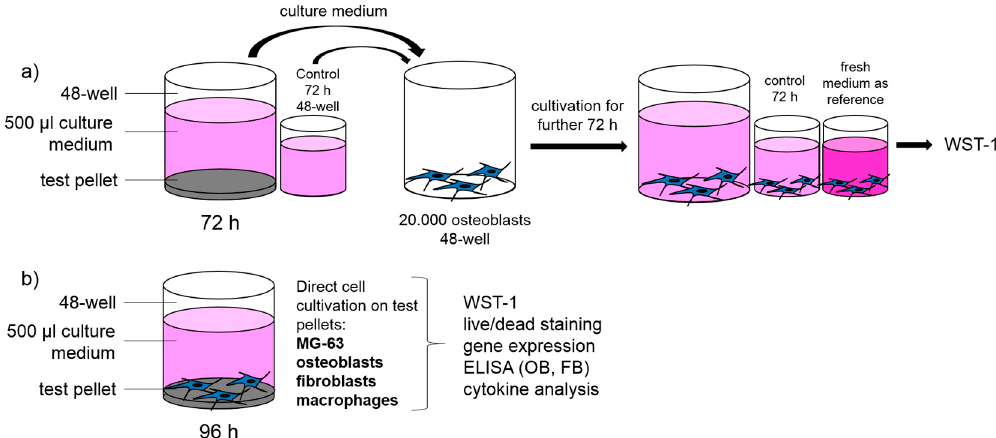
Figure 2. Schematic experiment set-up: ( a ) verification of potential cytopathic substances; and ( b ) analysis of biocompatibility of different titanium alloys with four types of cells.